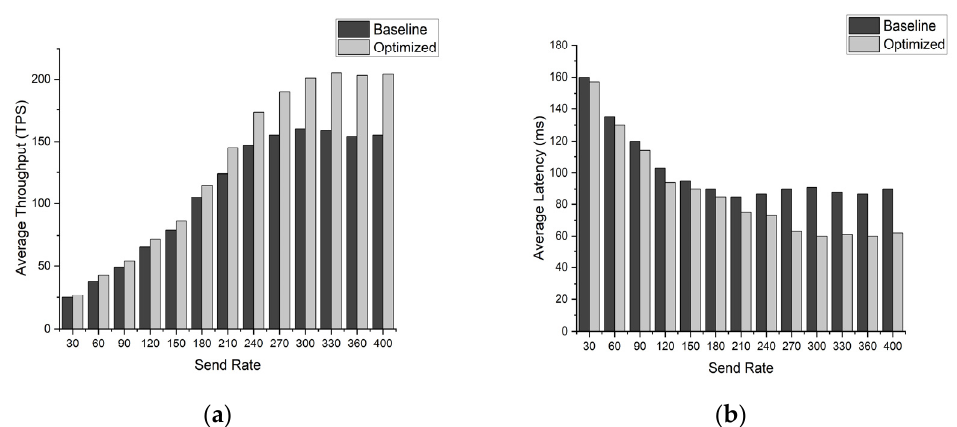
Figure 7. Average transaction throughput ( a ) and latency ( b ) with one TSO and one DSO.